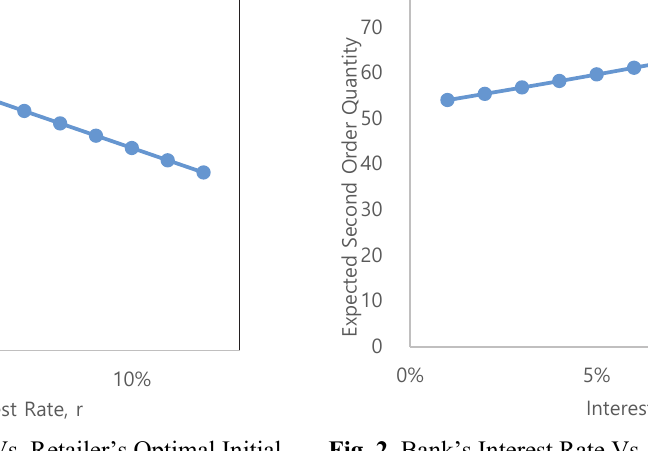
Fig. 1. Bank’s Interest Rate Vs. Retailer’s Optimal Initial Order Quantity